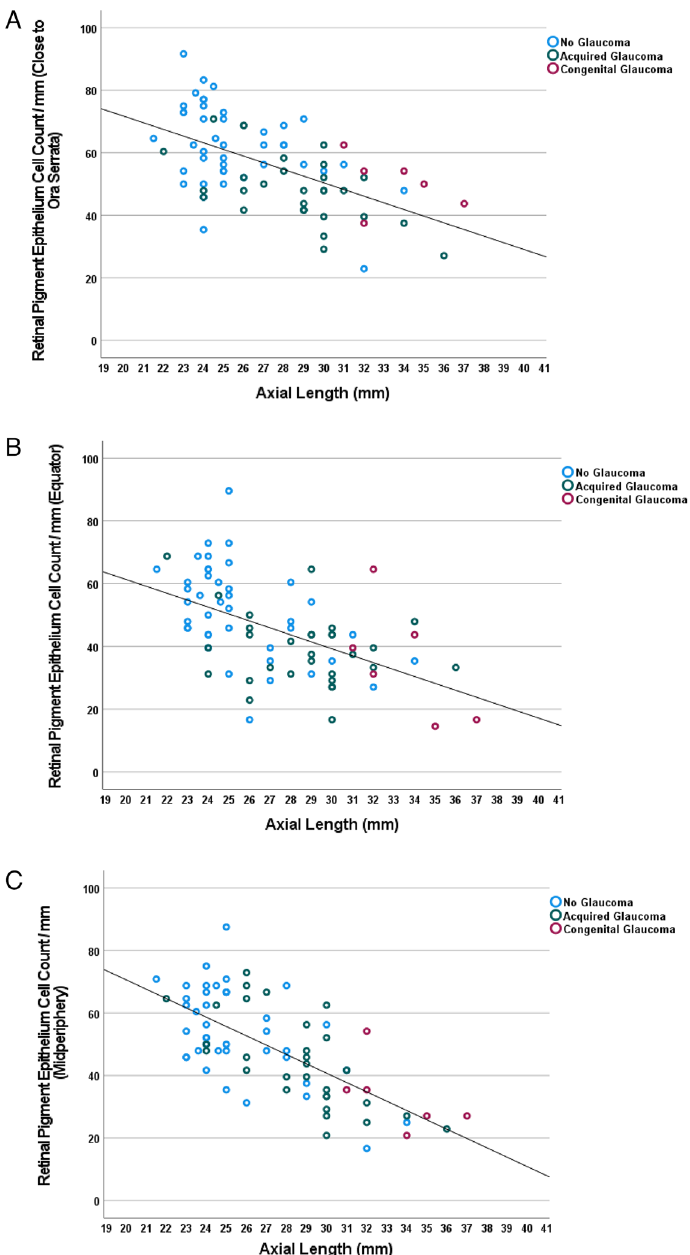
Figure 4. Scattergram showing the distribution of the retinal pigment epithelium cell count / mm in relationship to axial length, as measured close to the ora serrata ( a ), at the equator ( b ) and in the fundus midperiphery (midpoint between equator and posterior pole) ( c ), and at the posterior pole ( d ). ( a ) Equation of the regression line: Retinal Pigment Epithelium Cell Count/mm = − 2.14 × Axial Length (mm) + 114.4. ( b ) Equation of the regression line: Retinal Pigment Epithelium Cell Count/mm =− 2.21 × Axial Length (mm) + 105.5. Figure 4(c) Equation of the regression line: Retinal Pigment Epithelium Cell Count/ mm = − 2.98 × Axial Length (mm) + 130.7. ( d ). The association is statistically not significant ( P = 0.86, with eyes with congenital glaucoma (marked by red circles)